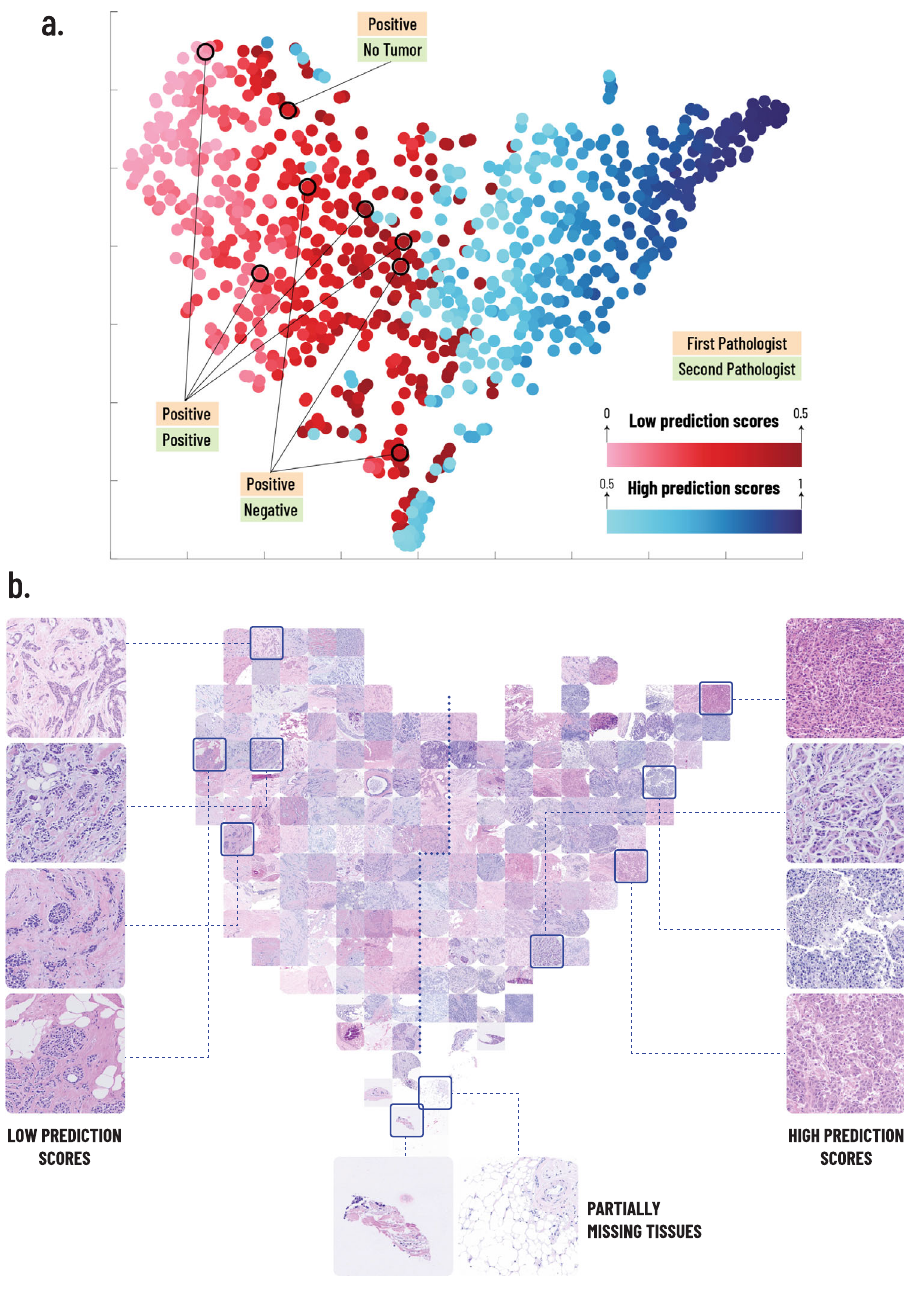
Fig.5|t-SNEembeddingforvisualizationoffeaturespace.a A2Dvisualizationof the imagefeaturevectors by applying t-SNE.Each point represents a singlepatient in the BCCA test set. The t-SNE embedding maps patients with similar image fea- tures to near points, and patients with dissimilar image features to far points. The points are colored by the PD-L1 prediction scores of their corresponding patients. The8patientsthatwereclassi fi edpositivebythe fi rstpathologistandlow-PSbythe